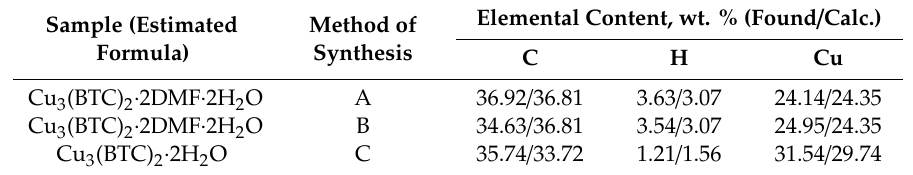
Table 1. The results of an elemental analysis for samples synthesized under di ff erent reaction conditions. Sample